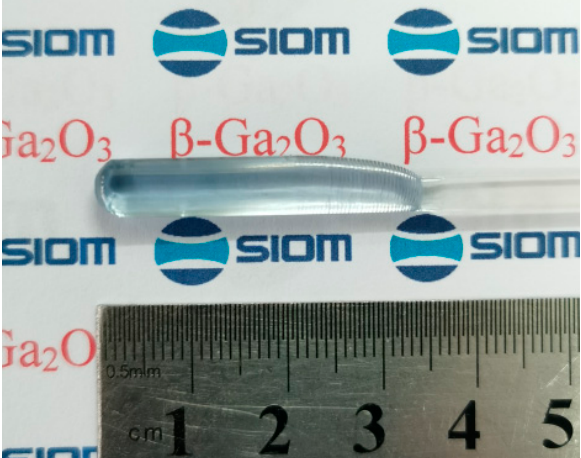
Figure 1. The photo of as-grown β -Ga 2 O 3 single crystal. The X-ray rocking curve was measured using a Bruker D8 Discover X-ray diffractometer with a Cu K α line at 40 kV and 40 mA. The optical transmittance spectrum was collected using a Lambda 1050+ UV/Vis/NIR spectrometer (PerkinElmer). Figure 2 shows the X-ray rocking curve of the β -Ga 2 O 3 (400) plane. The full width at half maximum (FWHM) is 100.8 arcsec. This shows that the β -Ga 2 O 3 crystal is a single crystal with good crystallization quality. Figure 3 shows the optical transmission spectrum of the β -Ga 2 O 3 single crystal. The β -Ga 2 O 3 single crystal wafer indicates high transmittance, between 80% and 82%, from the visible wavelength to the infrared (IR) wavelength region. The transmittance spectrum exhibits a cutoff absorption edge at around 255 nm. This was a result of the intrinsic absorption caused by the transition from the valence band to the conduction band [41].